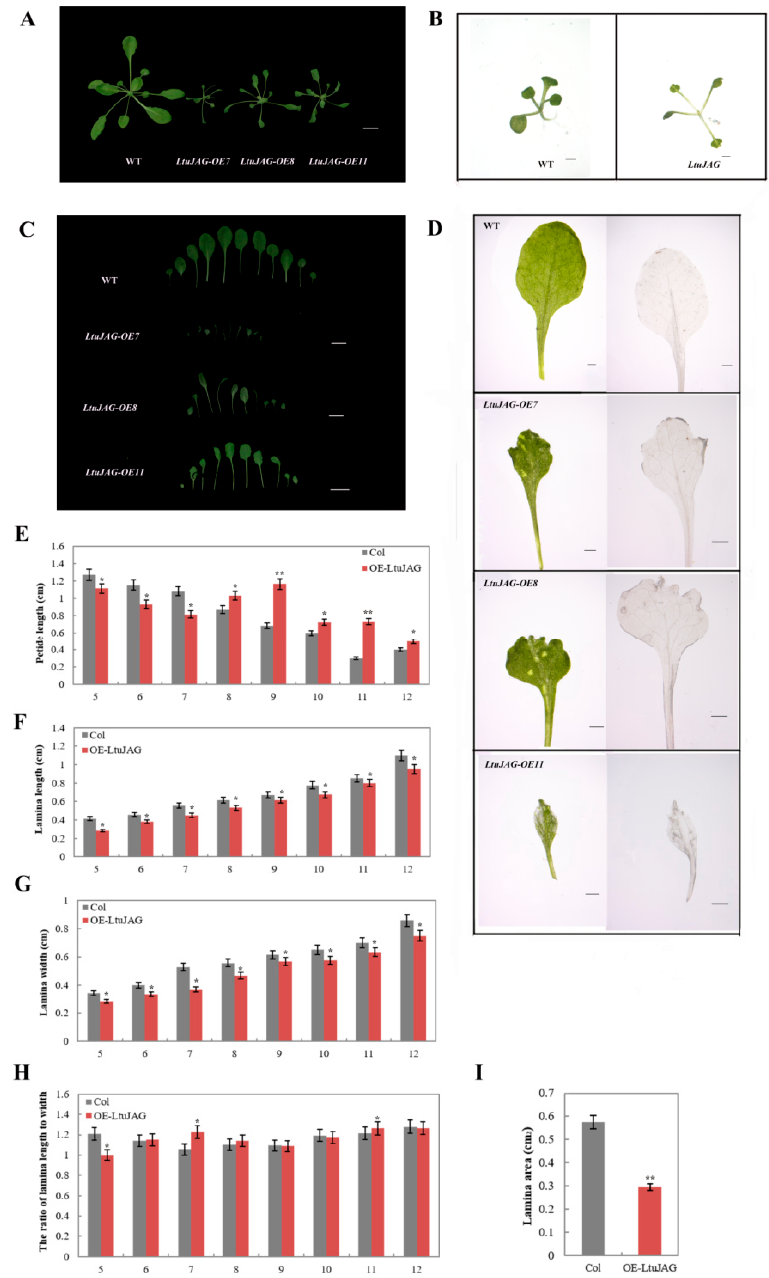
Figure 6. The margin serration phenotype of transgenic LtuJAG lines. ( A – D ): The transgenic line 35S::LtuJAG exhibited a phenotype causing petiole elongation, leaf serration and small leaf area at the 10 days ( B ) and 32 days ( A , C , D ) after seed germination. Scale bar = 1 mm and 1 cm; ( H , I ): Quantification of leaf lobes of transgenic LtuJAG lines, Col-0 was used as a wild-type control; ( E ): Quantification of the petiole lengths of 5th leaves to 12th leaves; ( F ): Quantification of the lamina length of 5th leaves to 12th leaves; ( G ): Quantification of the lamina width of 5th leaves to 12th leaves; ( H ): Quantification of the ratio of the lamina length to width; ( I ): Quantification of lamina area of 5th leaves. Leaves of plants grown for 32 days were examined, error bars showed SD (n ≥ 12). The asterisks indicate significant difference from the WT using the Student’s t -test (** p < 0.01, * p < 0.05).